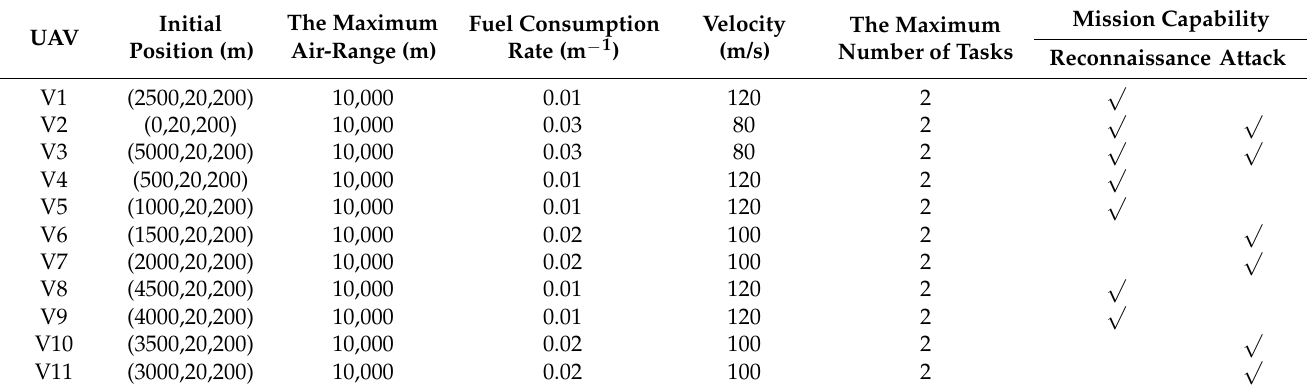
Table 1. The table of capability parameters of UAVs.